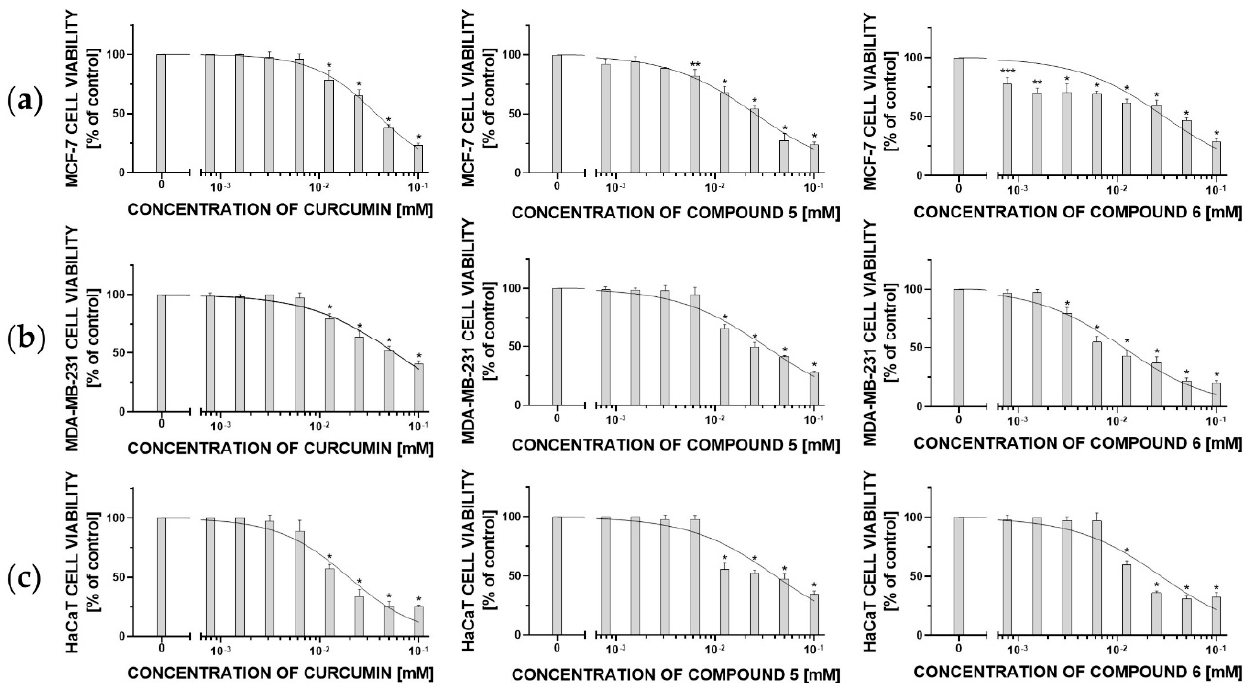
Figure 3. The cellular viability of the ( a ) MCF-7 cell line, ( b ) MDA-MB-231 cell line, and ( c ) HaCat cell line, after 24 h incubation with different concentrations of curcumin, compound 5 , and compound 6 . The cellular viability was measured by MTT Cell Viability assay. The results were presented as a percentage of control (mean ± SD, n = 3, * p < 0.0001; ** p < 0.01; *** p < 0.1).